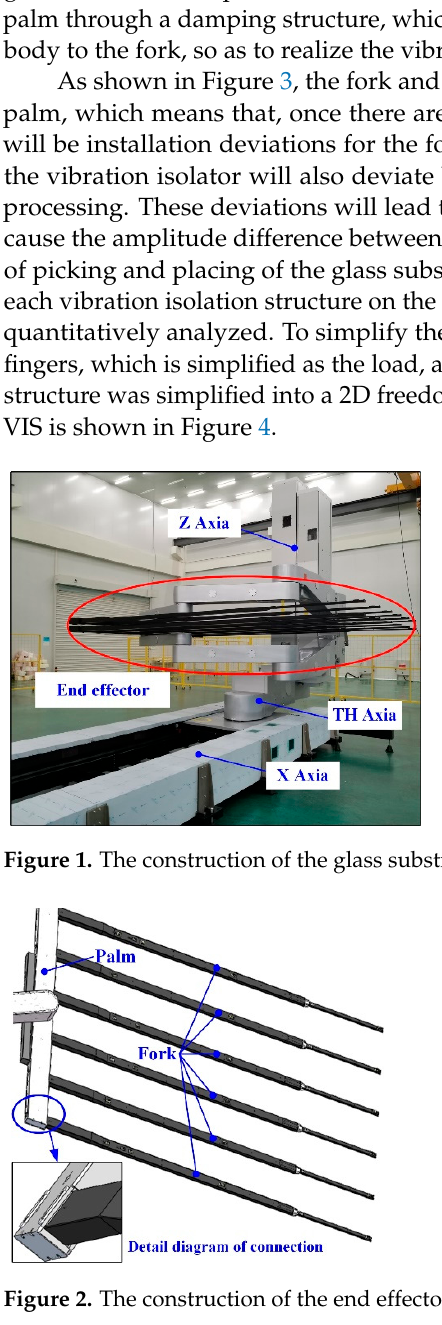
Figure 3. The details of the connection. Figure 4. Schematic diagram of freedom model for the 2D vibration isolation system. The differential equation of the system is (